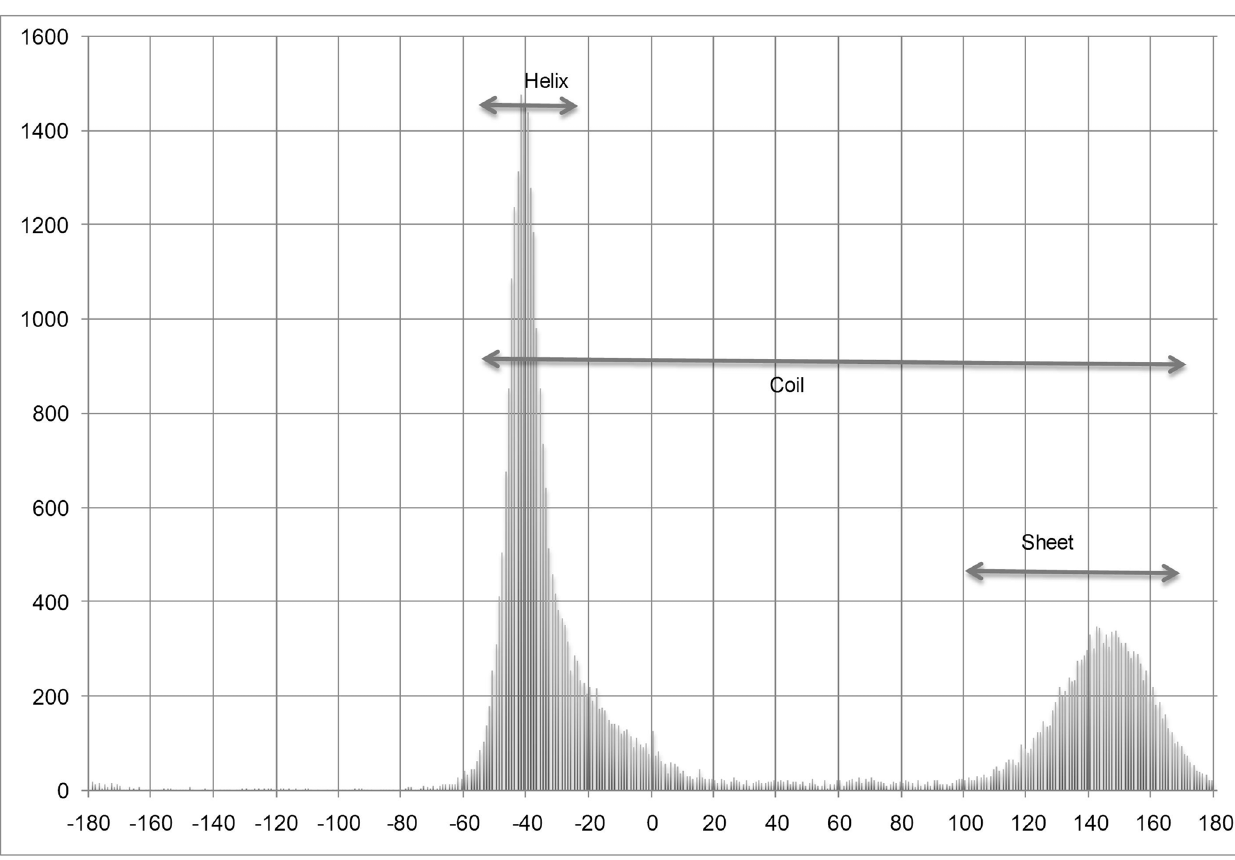
Figure 3. Normal psi angle distribution of Alanine.